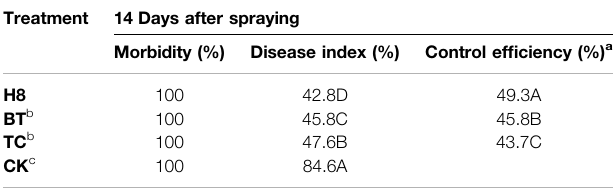
TABLE 4 | The Protective activity of compound H8 against Xanthomonas oryzae pv. oryzae in Vivo at 200 μ g/ml Treatment